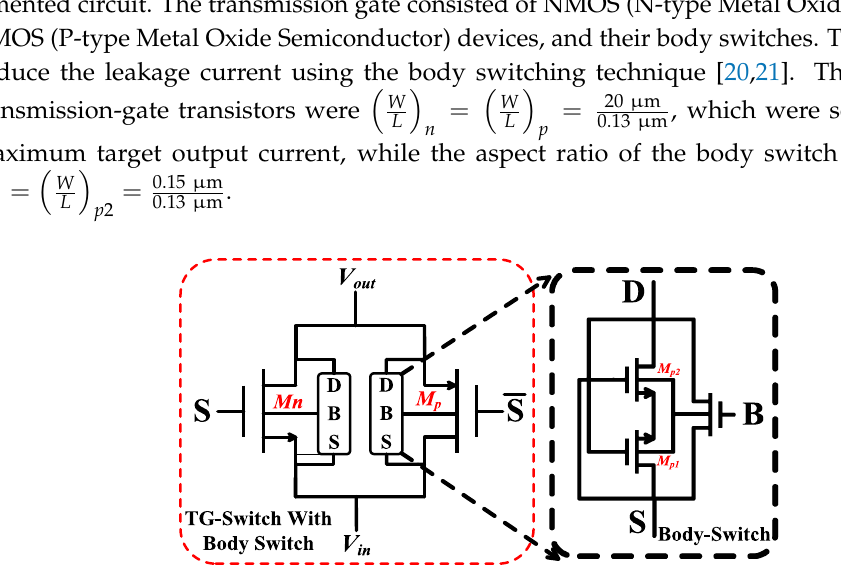
Figure 4. Transmission-gate switch with body switch that was used in the proposed SSC-DVS.